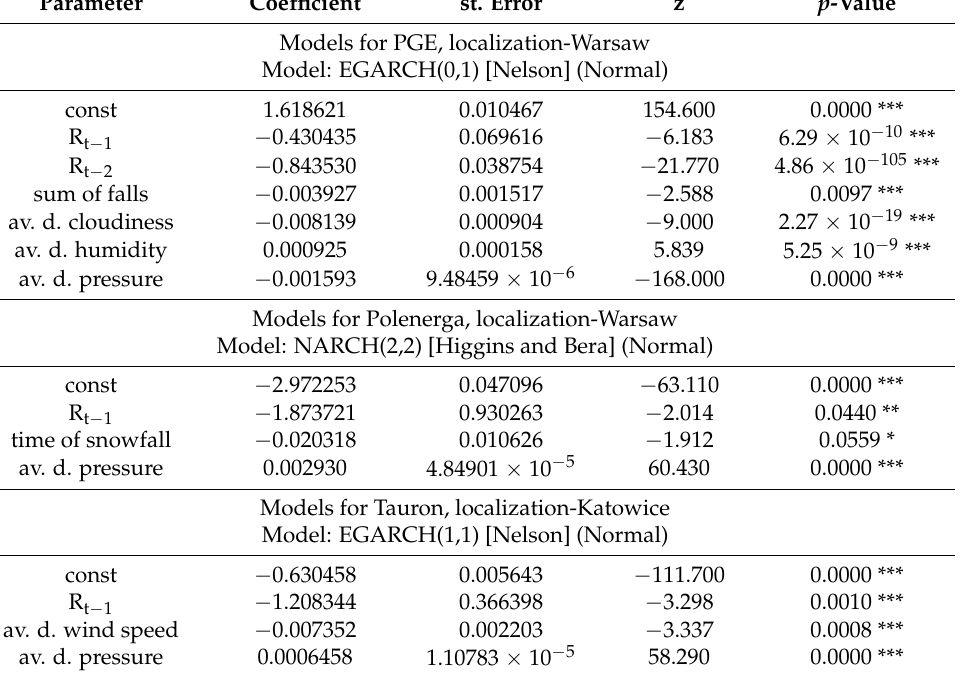
Table 2. Cont. Parameter